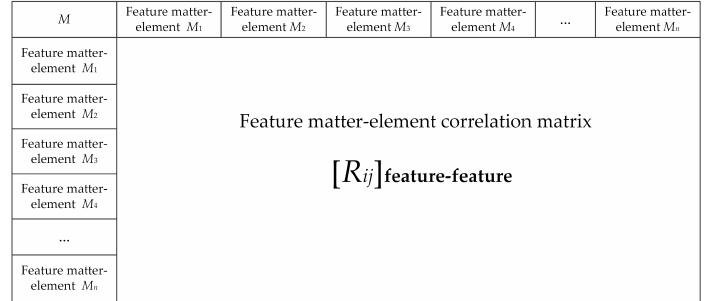
Figure 4. Feature matter-element correlation matrix.